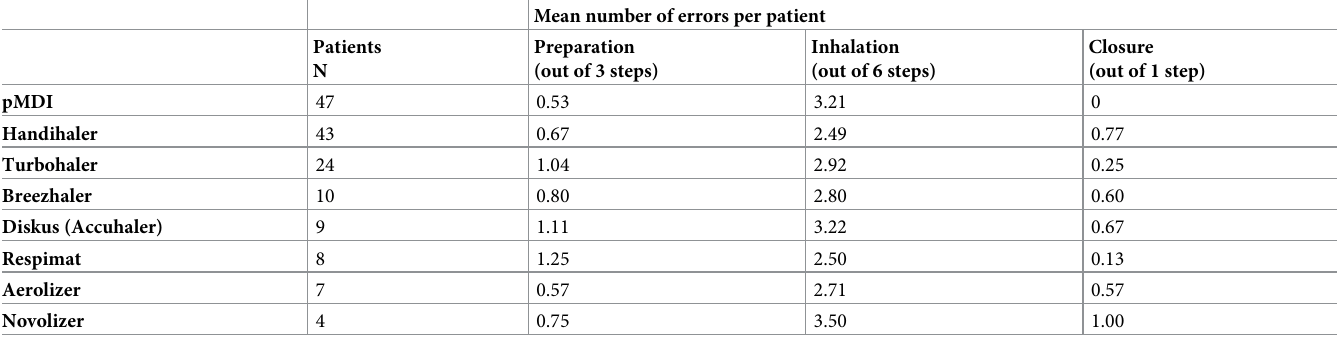
Table 2. Device-specific inhalation errors at baseline (N =